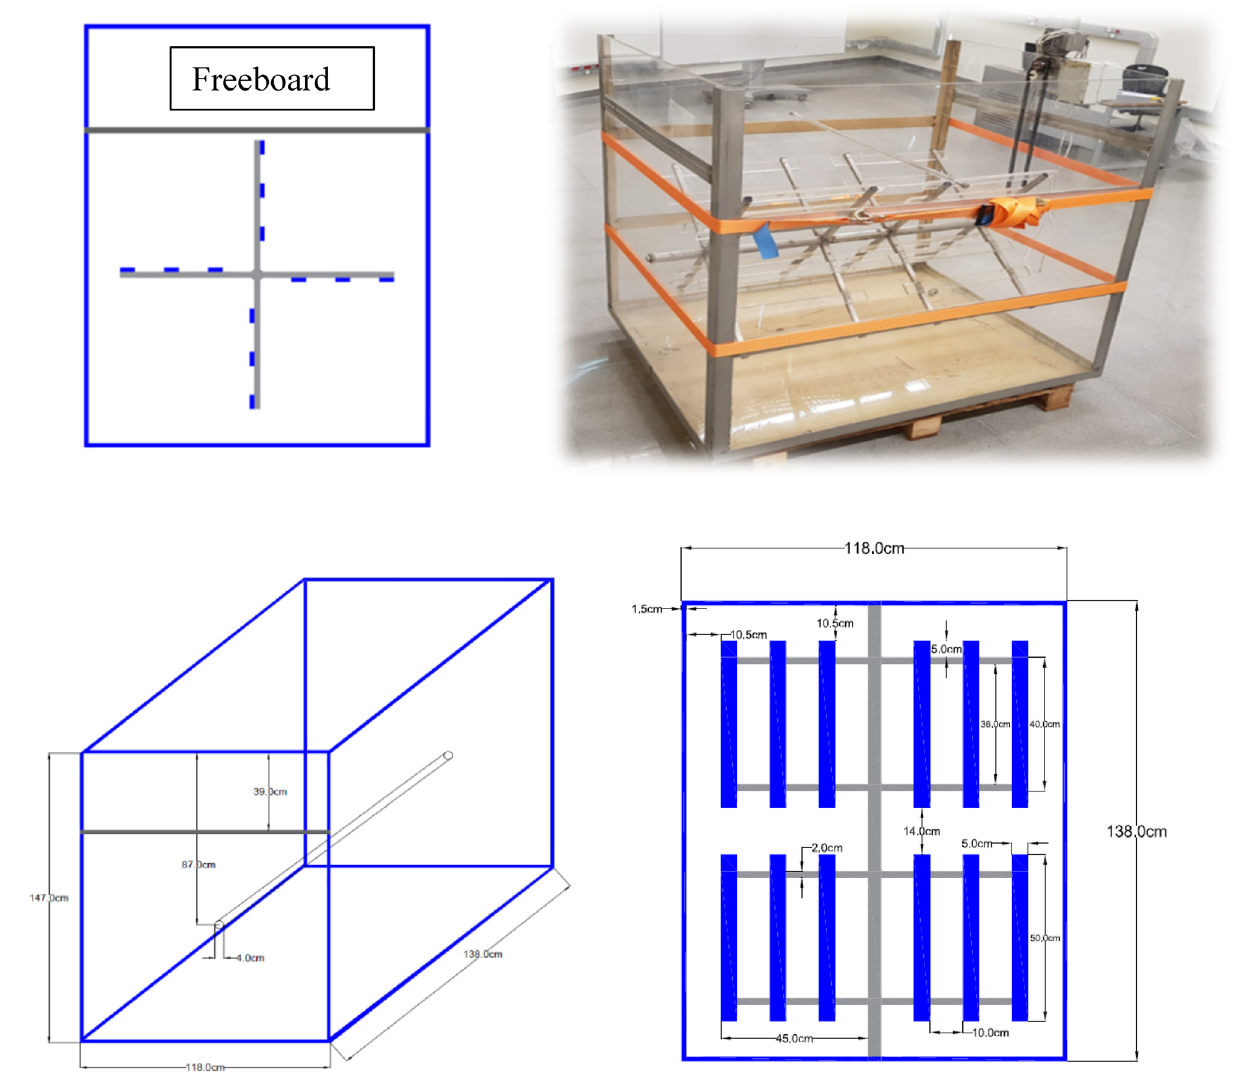
Figure 1. Schematic diagrams and basic dimensions of the experimental paddle flocculator.